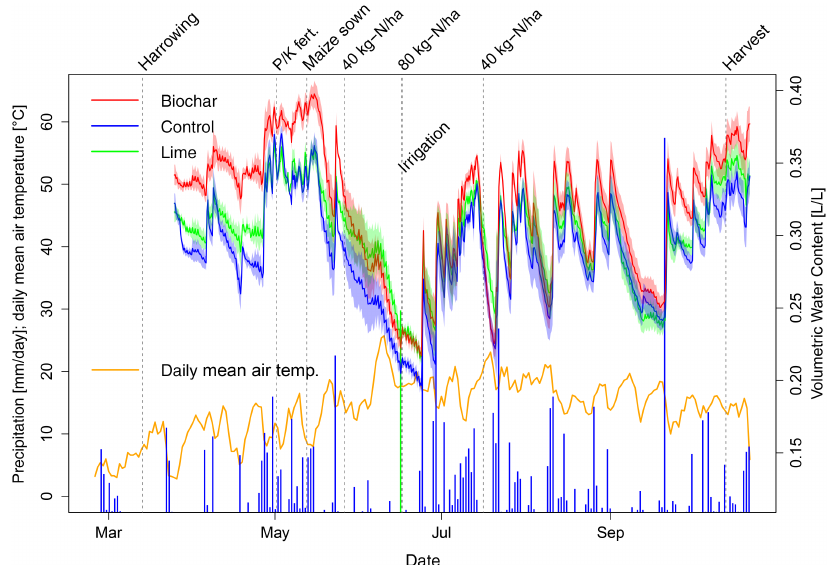
Figure 1. Soil moisture means for each treatment are shown in red, blue and green solid lines with 1SE as shaded area. Blue bars show the rainfall in mmd − 1 and the orange line is daily mean air temperature. The green bar indicates the irrigation of 33mm with the second N fertilisation.